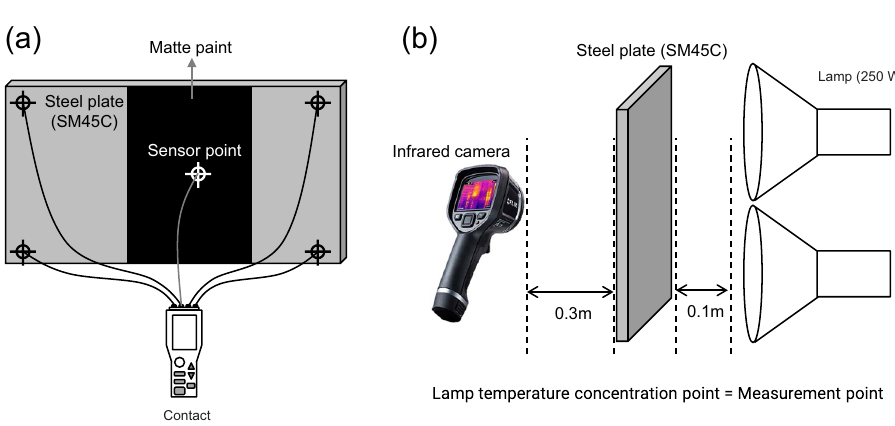
Figure 2. Experimental concept for deducing anchor head emissivity: ( a ) sensor location; ( b )